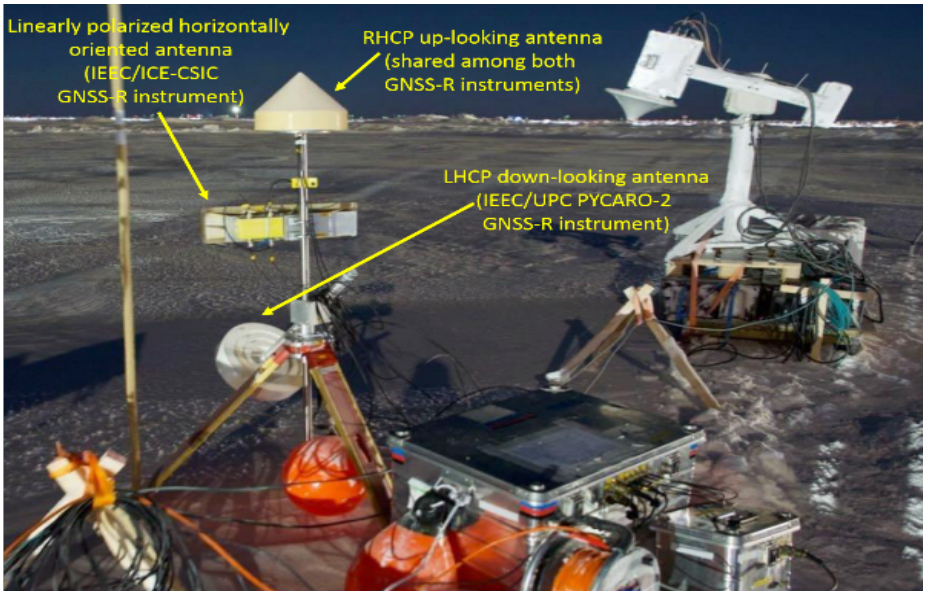
Figure 1. IEEC’s GNSS-R instruments: IEEC-ICE / CSIC GNSS-R instrument is formed by the zenith antenna and by the 5 × 1 patch array pointing to the horizon. IEEC / CTE-UPC GNSS-R instrument is formed by the zenith antenna and the 45 ◦ incidence angle LHCP antenna. [Credits: Gunnar Spreen].